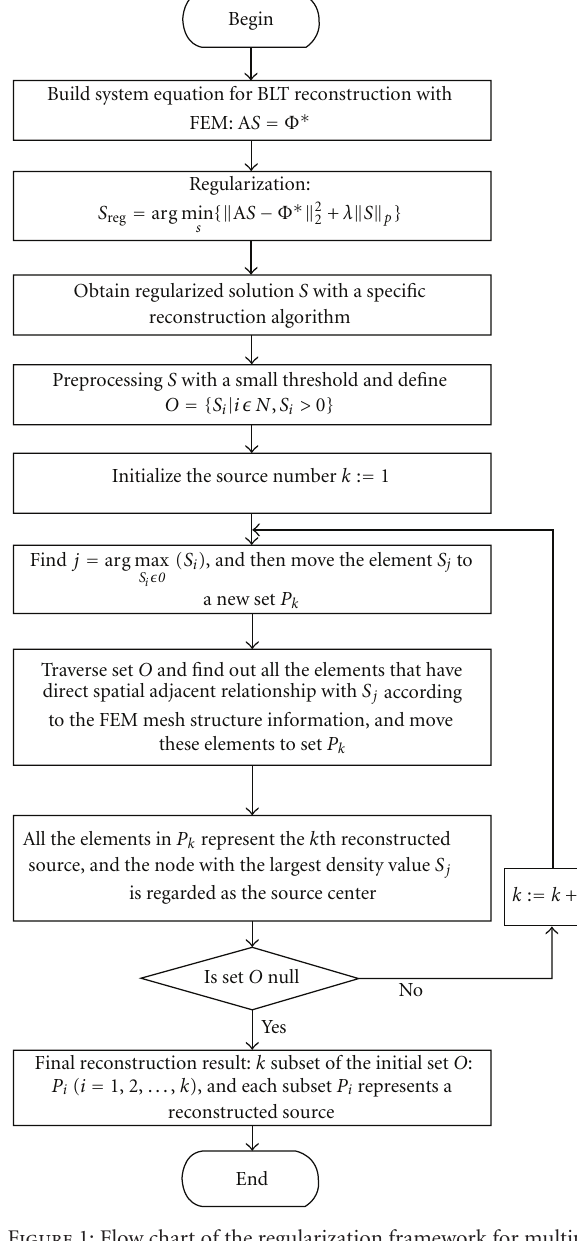
Figure 1: Flow chart of the regularization framework for multiple- source